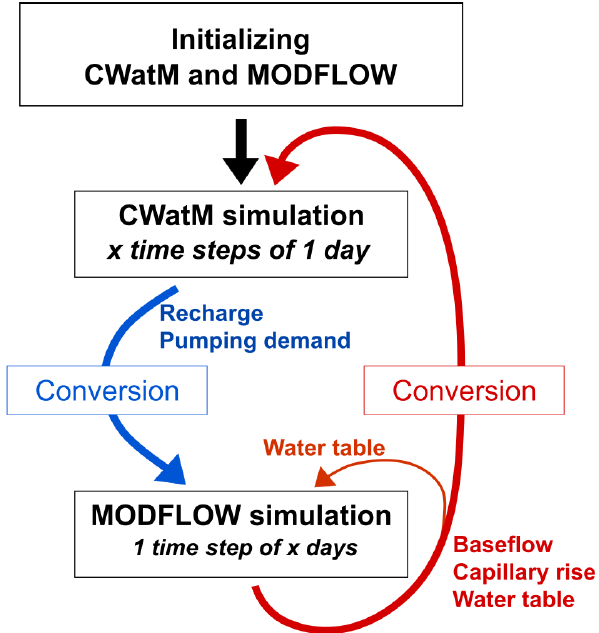
Figure 2. Scheme of the CWatM–MODFLOW coupling. Conver- sion refers to changing spatial resolution and units as well as passing to the MODFLOW model using BMI (blue case) or reading MOD- FLOW output (red case). Note that the MODFLOW model can be used at different space and time